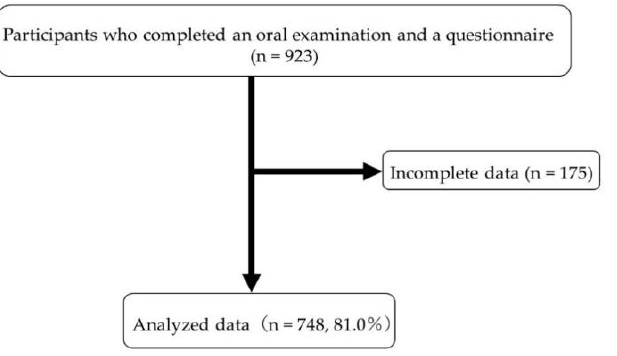
Figure 1. Flowchart of the complete data, excluding incomplete data, of those who completed the oral examination